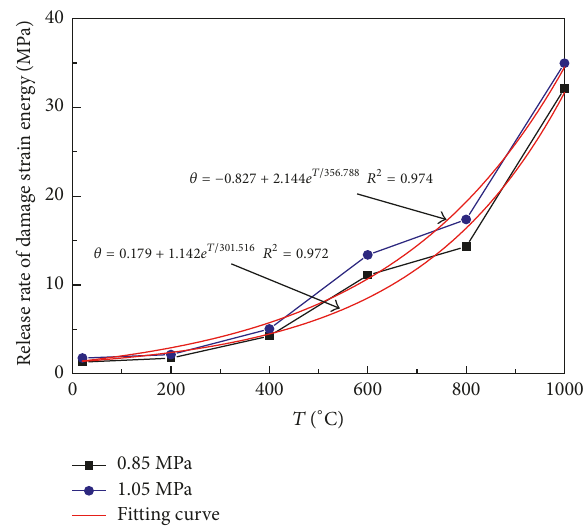
Figure 9: Relation of release rate of damage strain energy and